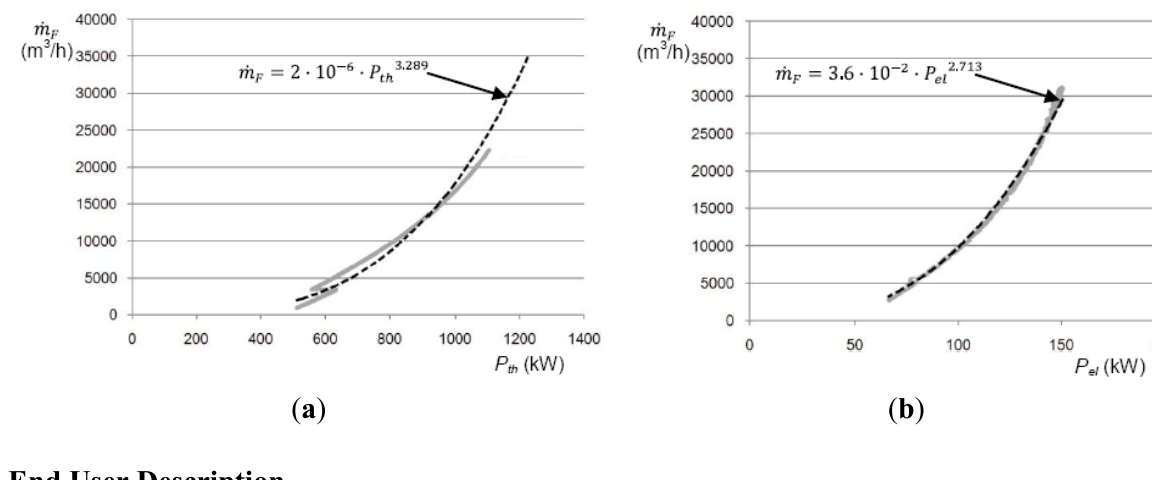
Figure 5. ( a ) Thermal and ( b ) electric output control equations.